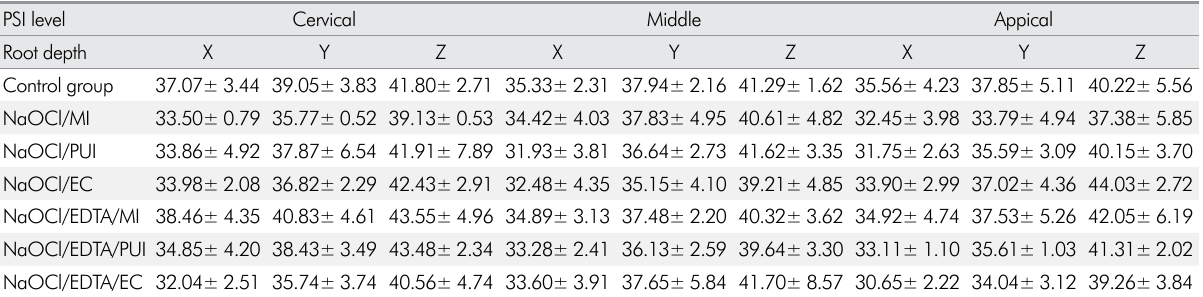
Table 2. The means and standard deviations of dentin microhardness at the three root levels (cervical, middle and